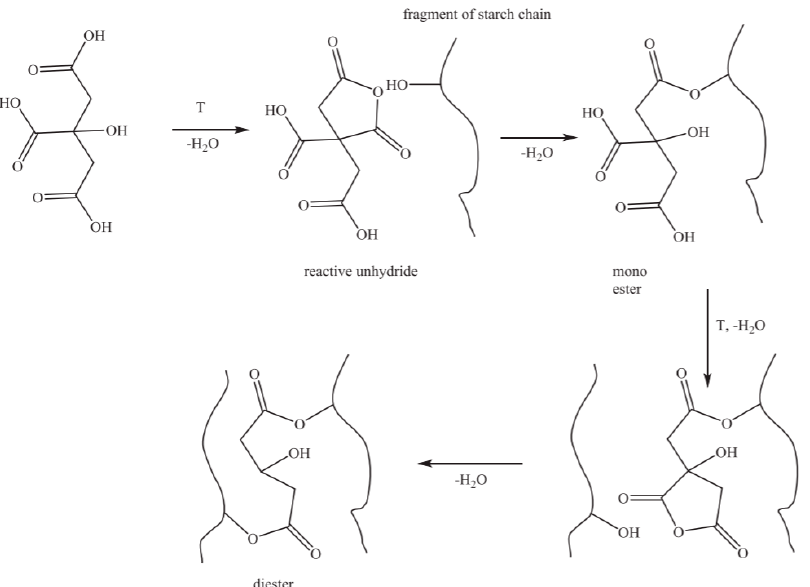
Figure 2. The mechanism of starch esterification by citric acid Reprinted/adapted with permission from Ref. [12]. Copyright © 2016, Elsevier.